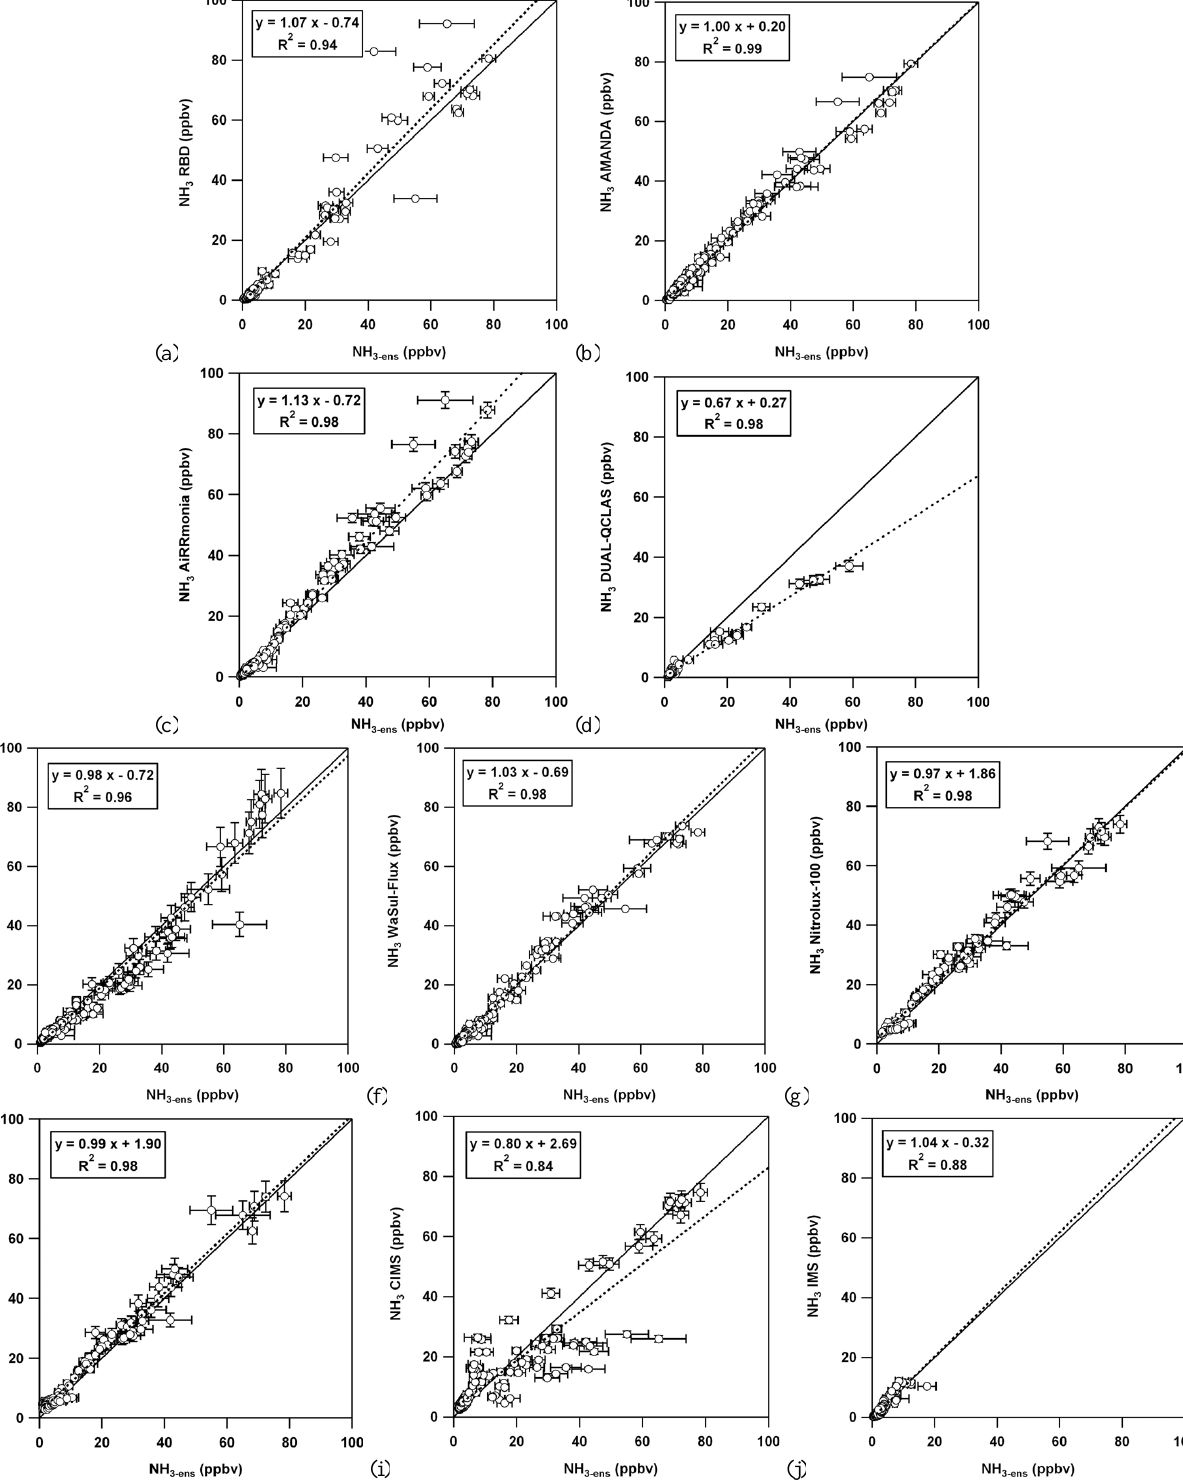
Fig. 4. Scatter plots showing correlation of hourly NH 3 concentrations ( z =1.1m) between all instruments and the NH 3 − ens screened for wind direction (150–310 ◦ ). The horizontal error bars calculate the statistical standard error. For AiRRmonia, DUAL-QCLAS, c-QCLAS, Nitrolux-100, CRDS and CIMS the vertical error bars mark the estimated accuracy (Table 1). The solid line gives the 1:1 line and the dashed line the result of the axis